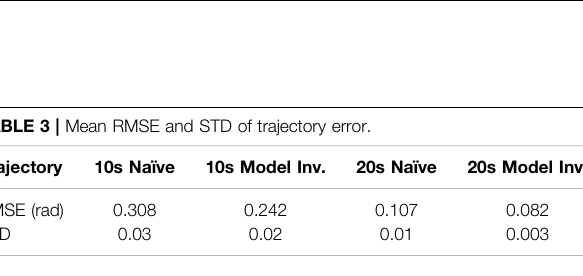
FIGURE 11 | Single joint experimental results: (A) 10 s trajectory, (B) 20 s trajectory.